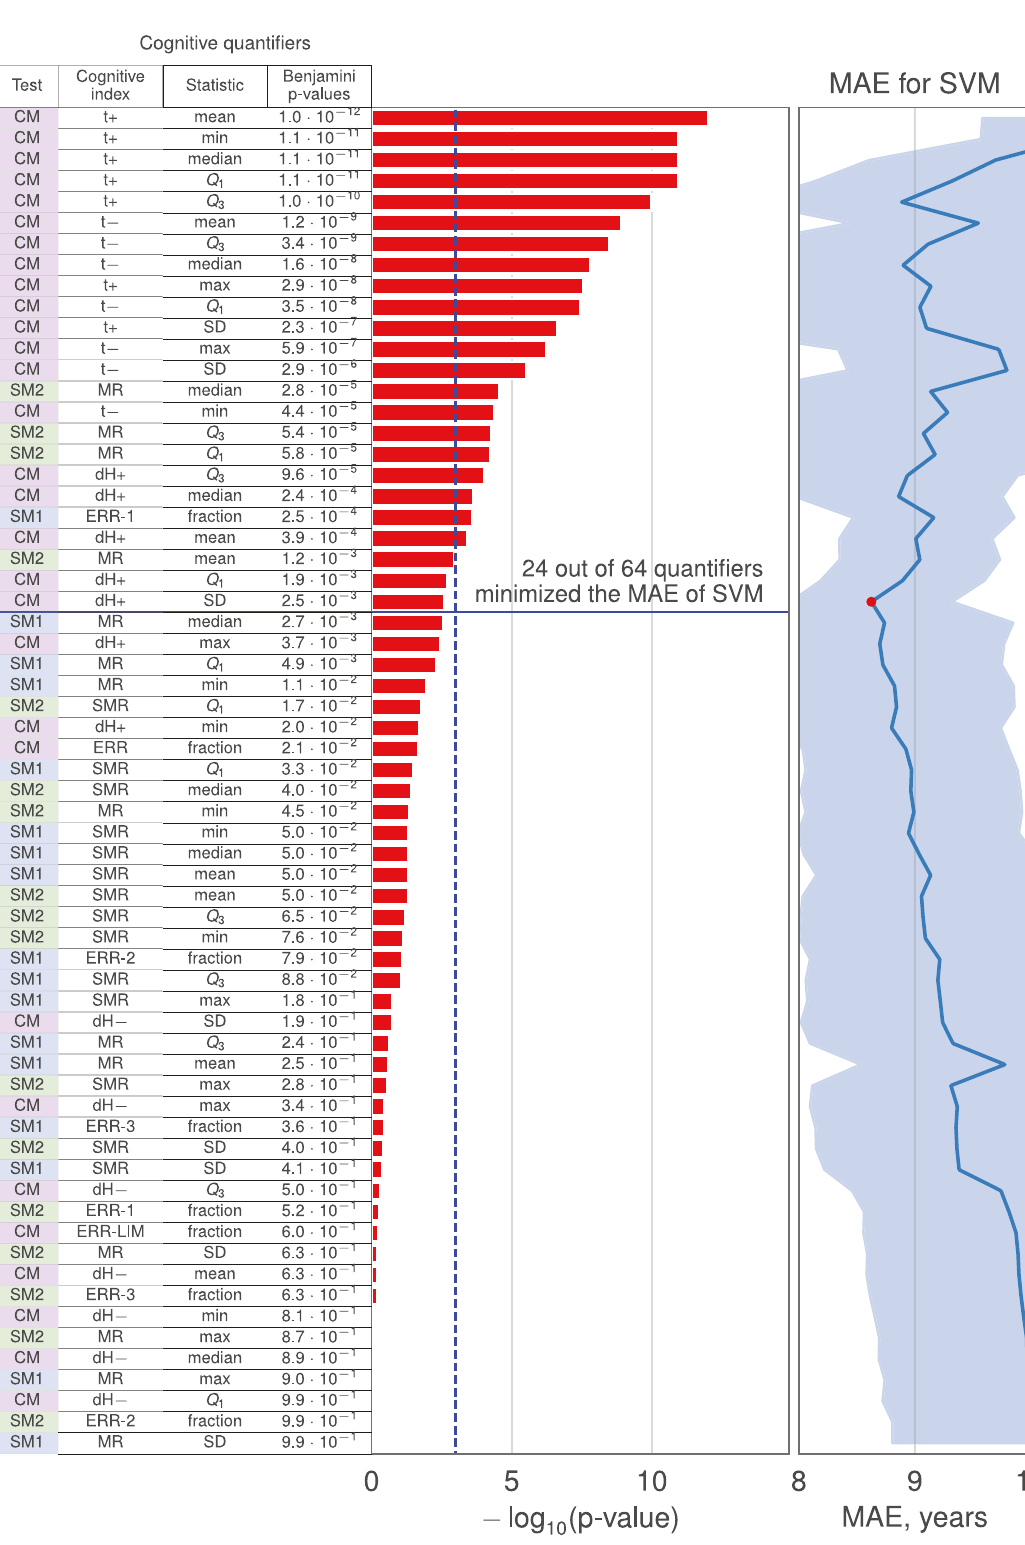
Fig. 3 The optimal subset of quanti fi ers for the Cognitive clock based on the SVM model obtained by minimization of MAE over number of top-ranked quanti fi ers. Cognitive quanti fi ers are ordered by their Benjamini p -values of Pearson 4th and 6th rows) outperform other clocks by value of MAE (SM1 SMR) and motor reaction times (SM1 MR) in the arithmetic test. estimated on outcomes of kNN model. The model that predicts DNAmGrimAge uses only 13 top-ranked DNAmPhenoAge clock based on PhenotypicAge and DNA features that includes the same indices except the motor reaction methylation, yields to poor quality of prediction by the cognitive time. As illustrated on Supplementary Fig. S5, epigenetic ages (3rd,